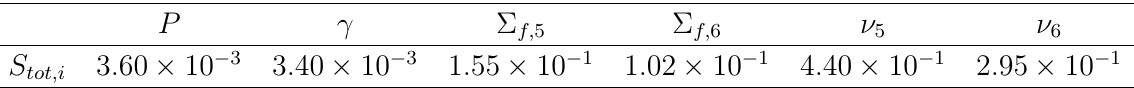
Figure 3: (a) Pdf representation of k using different polynomials orders and number of eff samples compared with the reference MC sampling. (b) Normal probability plot for the 3 rd order PCE. Blue crosses are the related to the sampling whereas the dashed line is the reference Gaussian. Table 4: Total sensitivity indices for k . Only the neutronics parameter give relevant eff contribution to the